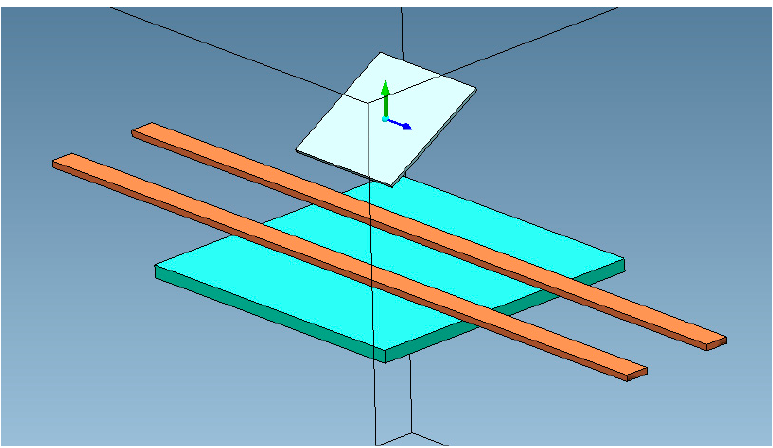
Figure 2. 3D geometry of the FE model.